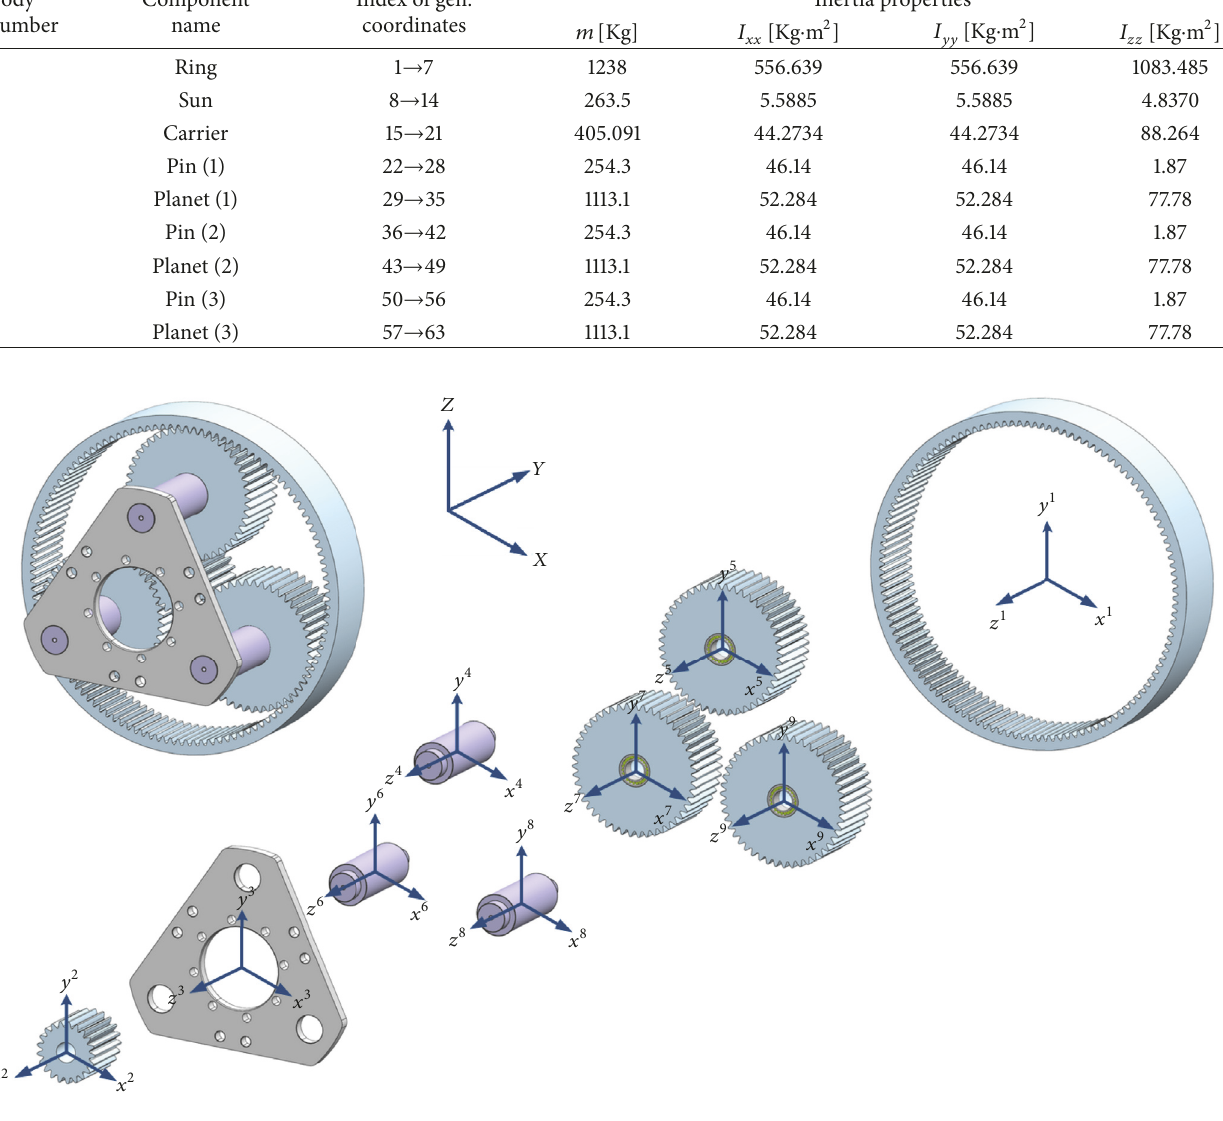
Figure 7: Multibody system model of planetary stage, stage